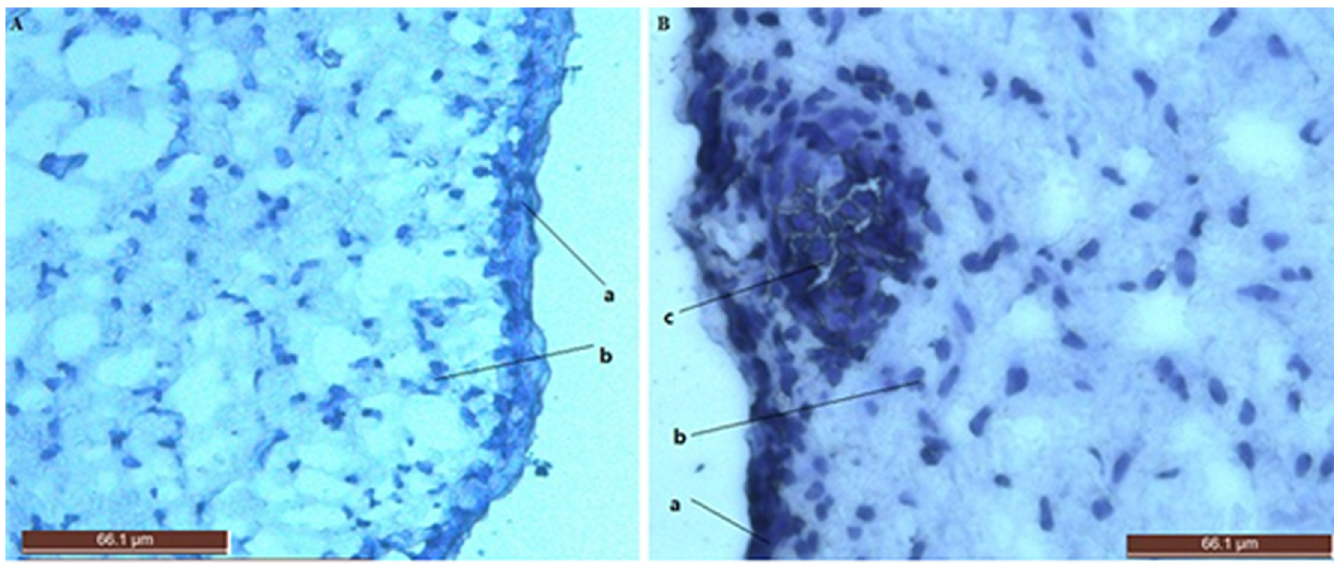
Fig 1. Skin sections during the initiation of secondary hair follicle. a.Stage 0 of secondary HF morphogenesis in 87E fetal ovine skin sections (200×).hematoxylin stained section. (a)Epidermis; (b)eukaryotic cells.b.Stage 1 of secondary HF morphogenesis in 96 E fetal ovine skin sections(400×). (a)Epidermis; (b)eukaryotic cells;(c)hair placode.